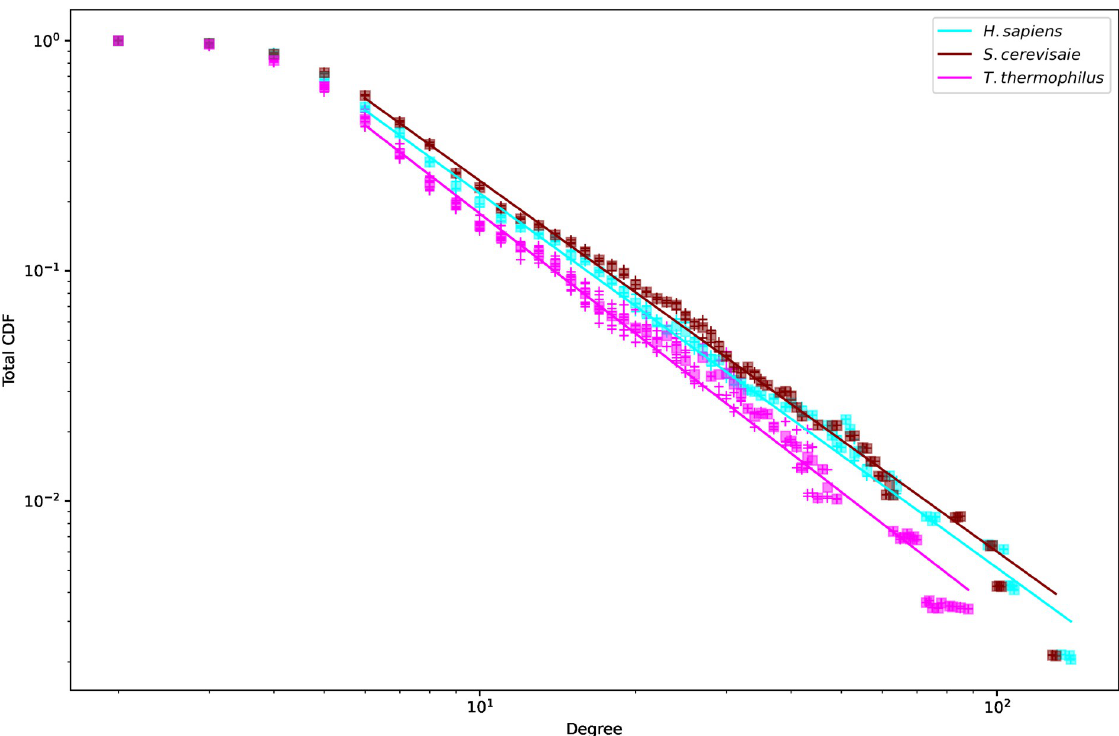
Fig 6. Cumulative density function (CDF) of degrees. The CDF of each individual file is plotted using colored ‘+’ markers. The final aggregate CDF for the three species was obtained by averaging the individual CDF at each degree and is plotted in square markers. The straight line is the fit to a power law of the average CDF. The resulting exponents are given in Table 2.